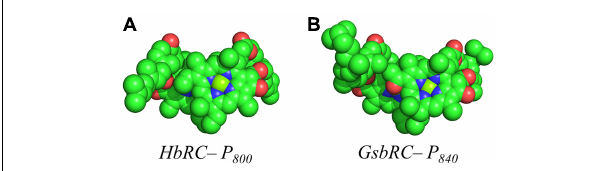
FIGURE 10 | Space filling models of (A) P 800 from the HbRC and (B) P 840 from the